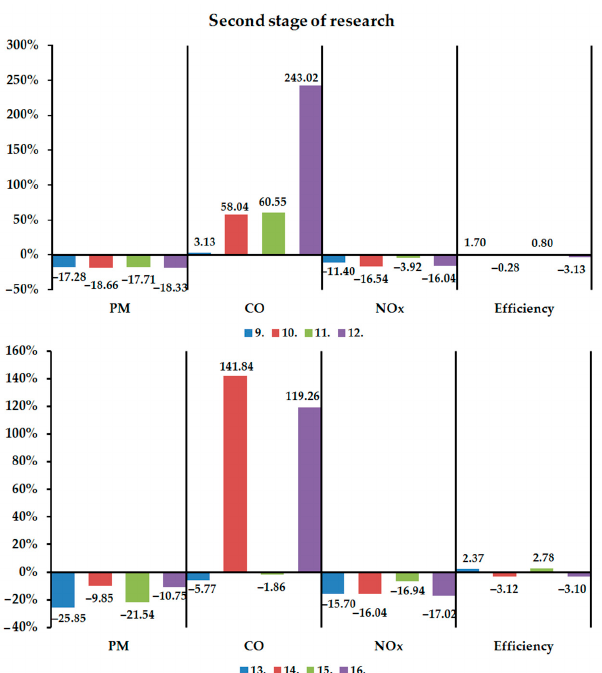
Figure 14. Changes in emission and efficiency parameters of the combustion process obtained for the second stage of research (cycles from 9 to 16).